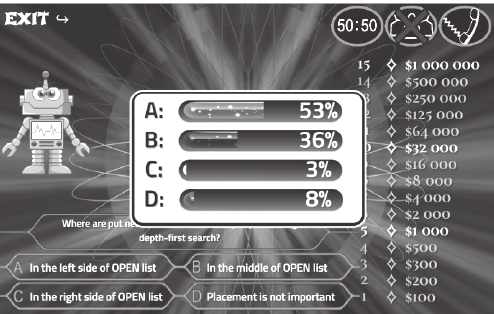
Fig. 4. Game interface for knowledge